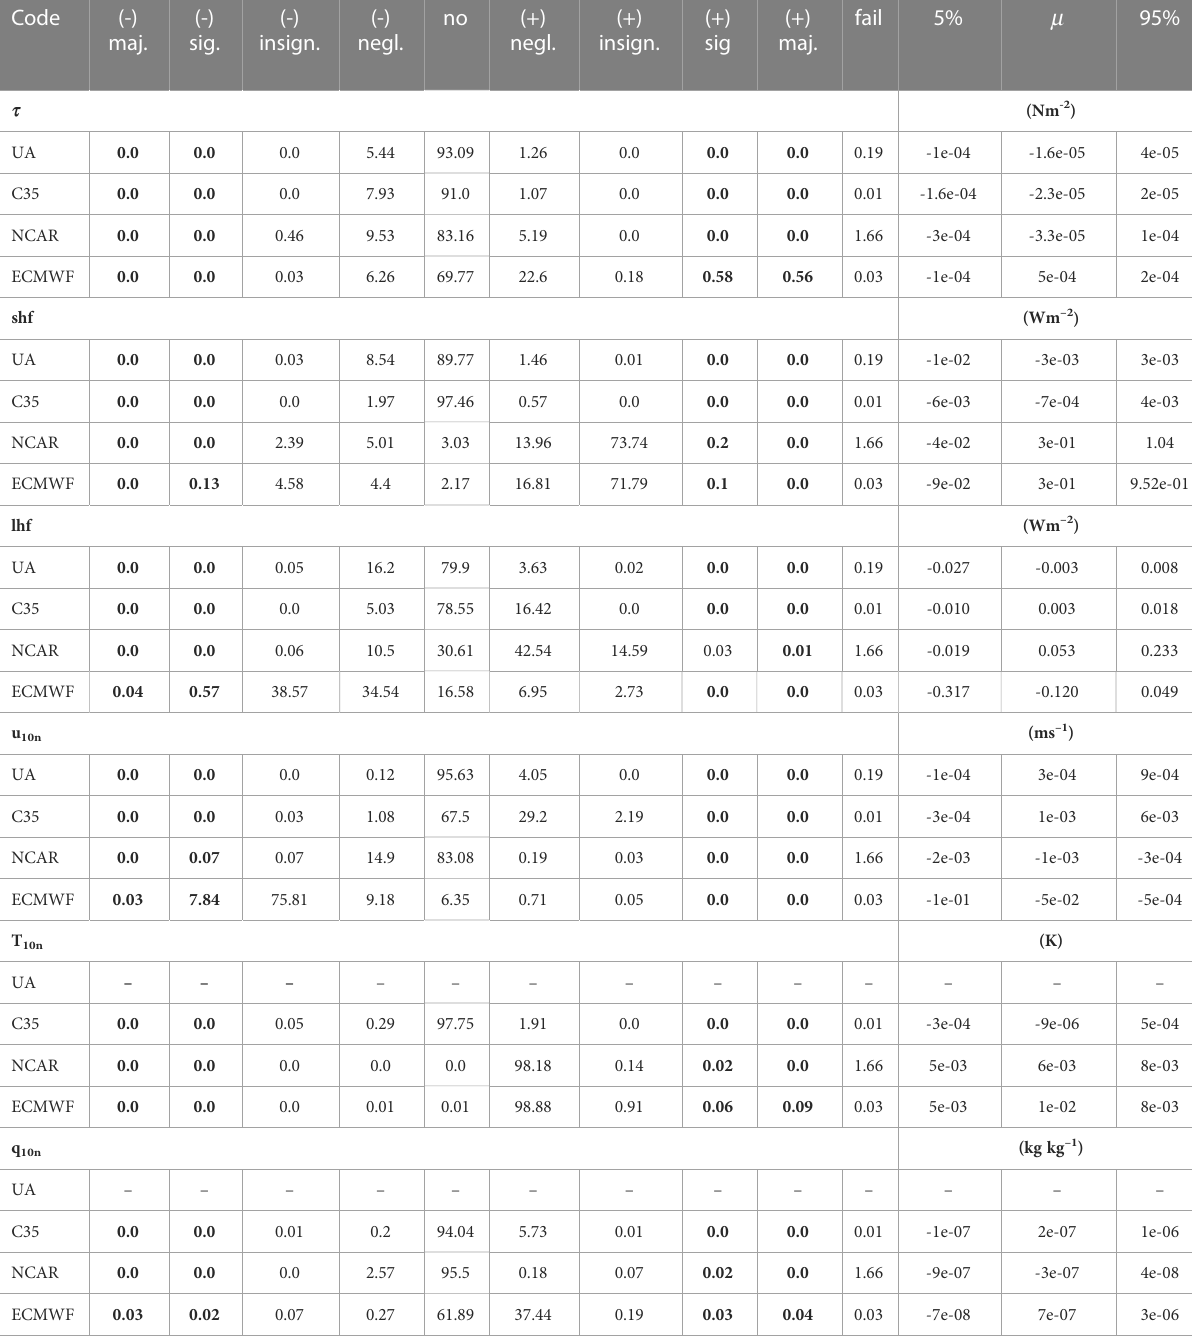
TABLE 6 Comparison of TSF and adjusted SSV results with those from existing software ( D X = X AirSeaFluxCode -X Developers ’ ). Code (-) maj.